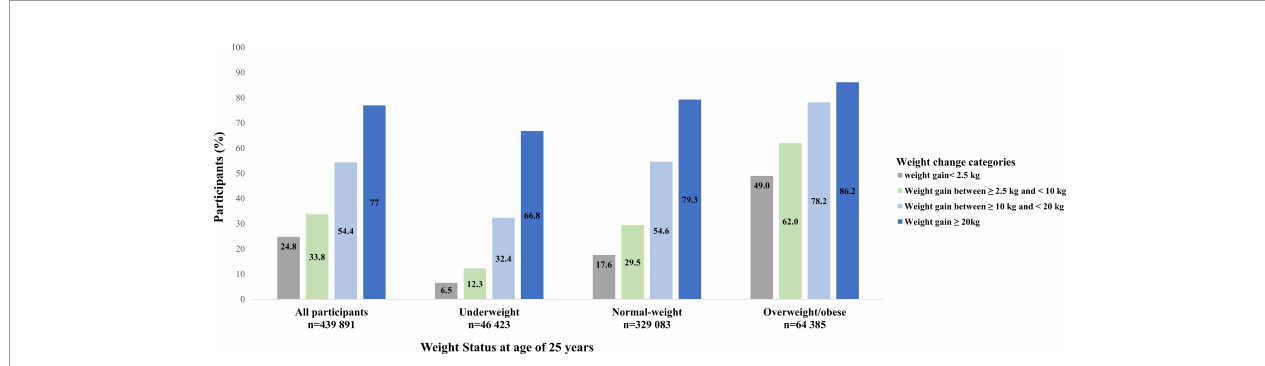
FIGURE 2 | The proportion of participants with metabolic syndrome by BMI categories at age 25 years and weight gain categories from young to middle